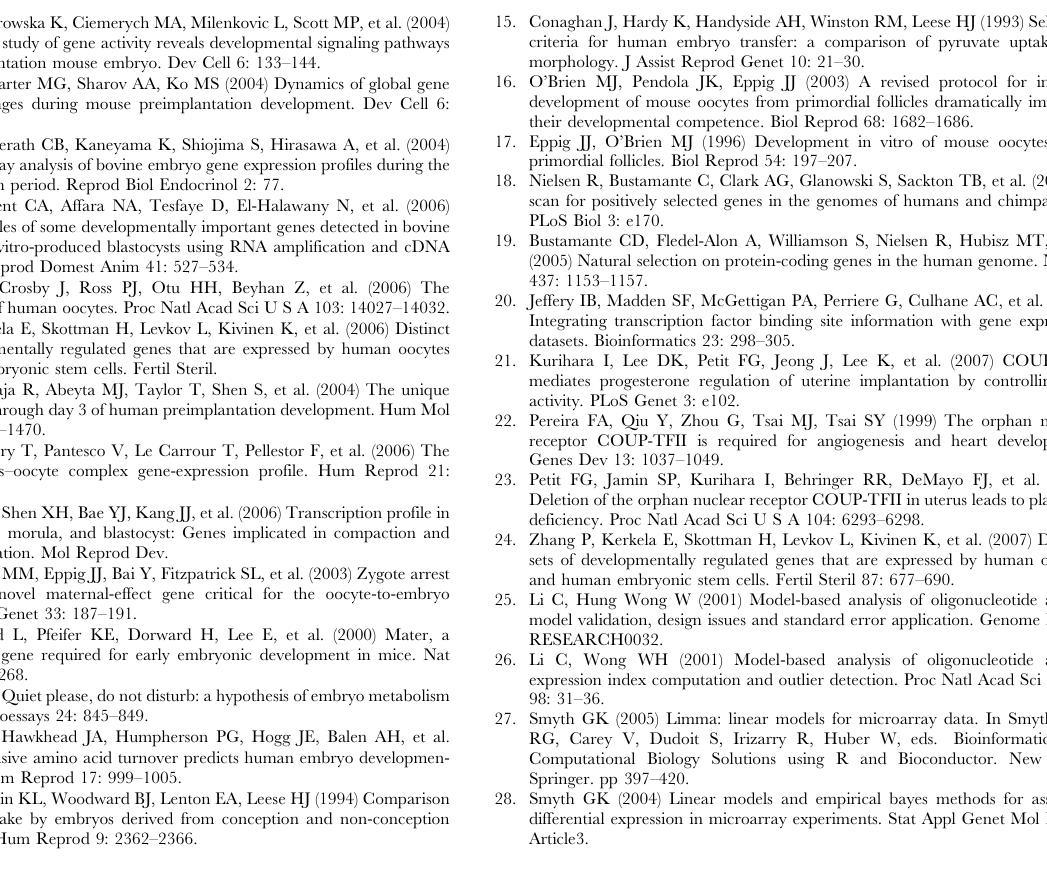
bars represent the number of probe sets with lower expression, the orange those with higher expression and the red ones the sum of the two. Found at: doi:10.1371/journal.pone.0007844.s025 (9.93 MB TIF) Figure S7 Differential expression in mice. Yellow bars represent the number of probe sets with lower expression, the orange those with higher expression and the red ones the sum of the two. Found at: doi:10.1371/journal.pone.0007844.s026 (6.75 MB